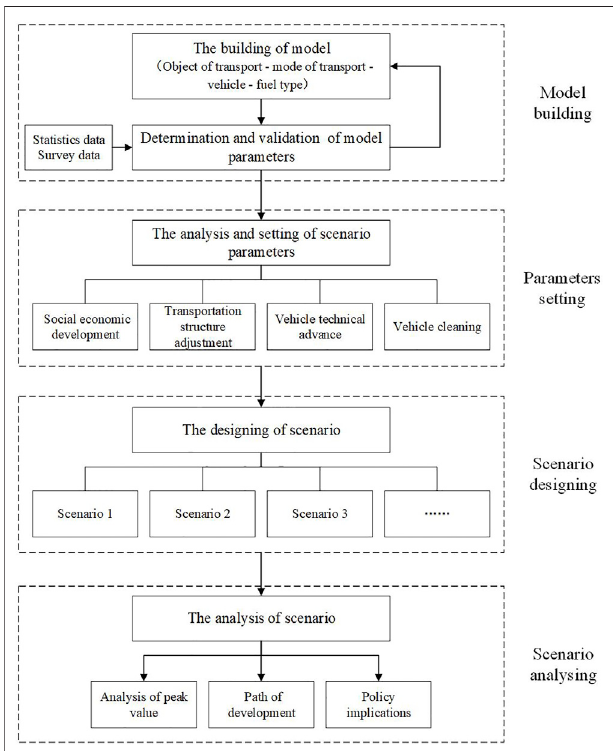
FIGURE 1 | The framework of the